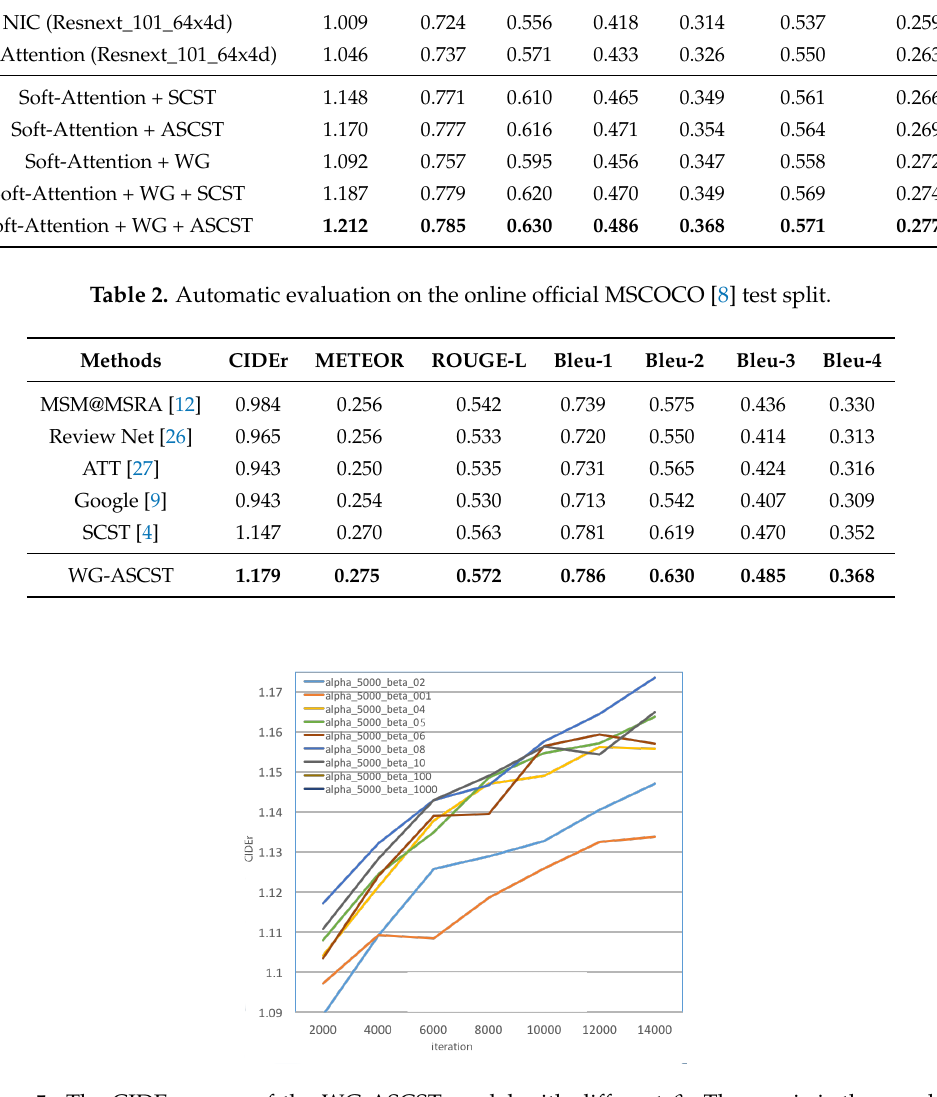
Figure 5. The CIDEr scores of the WG-ASCST model with different β . The x -axis is the number of iterations, and the y -axis is the CIDEr score. All the models in this figure have the same alpha. alpha_5000_beta_01 means the β of the ASCST model is